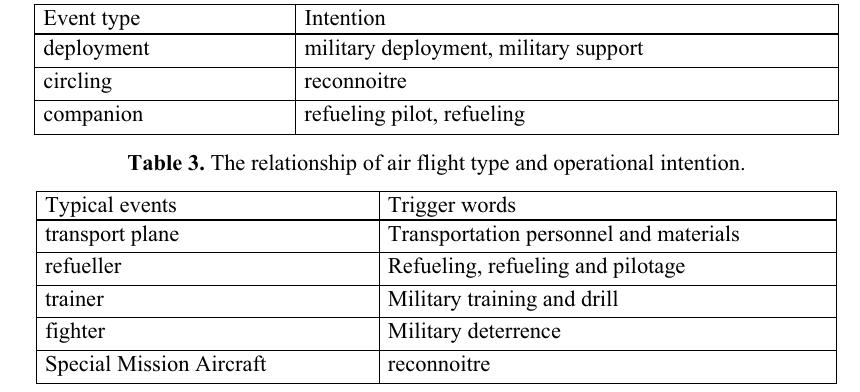
Table 4. The relationship of location and operational